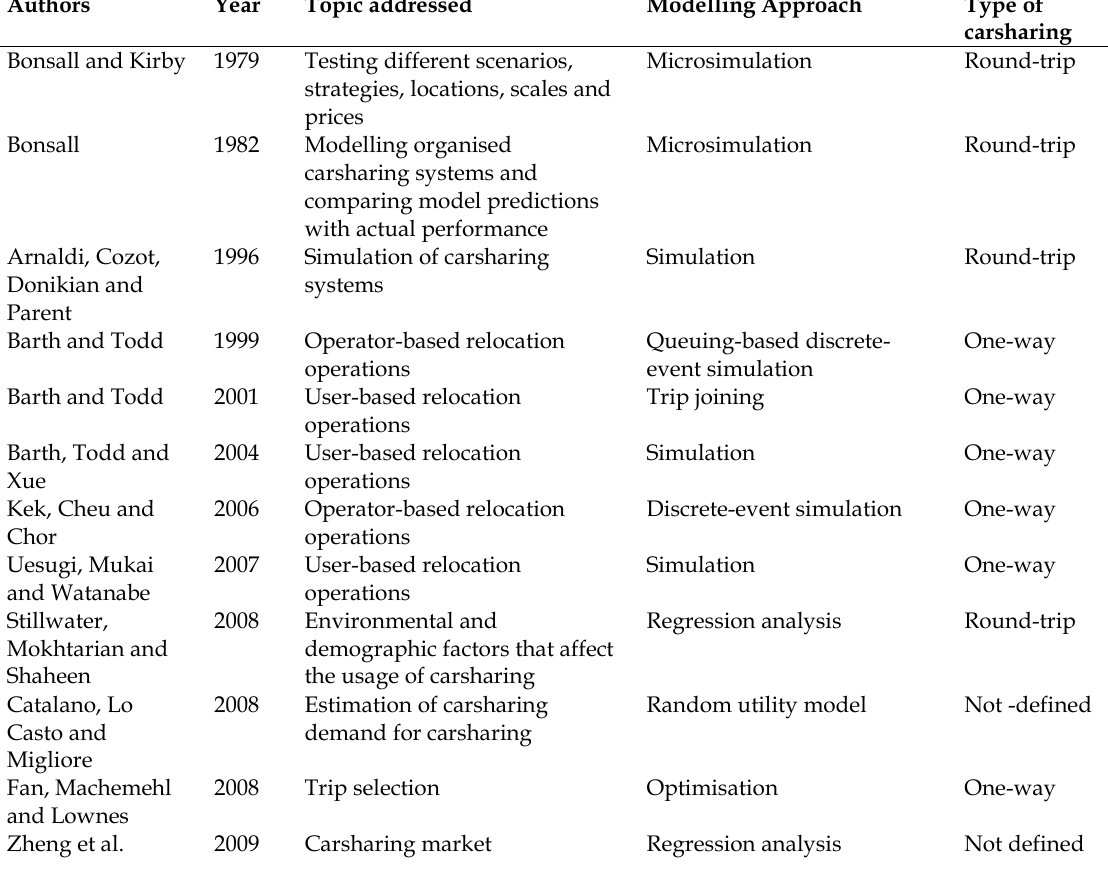
Table 1 Summary of the studies